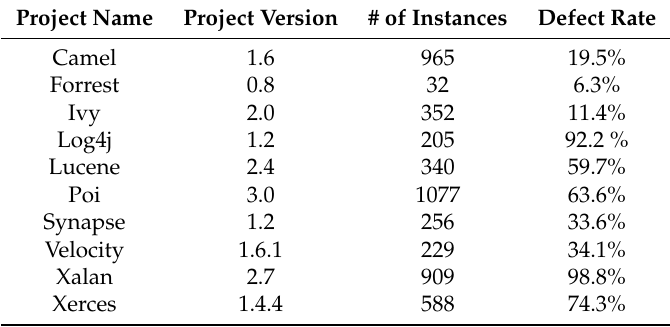
Table 2. The 10 projects used in this